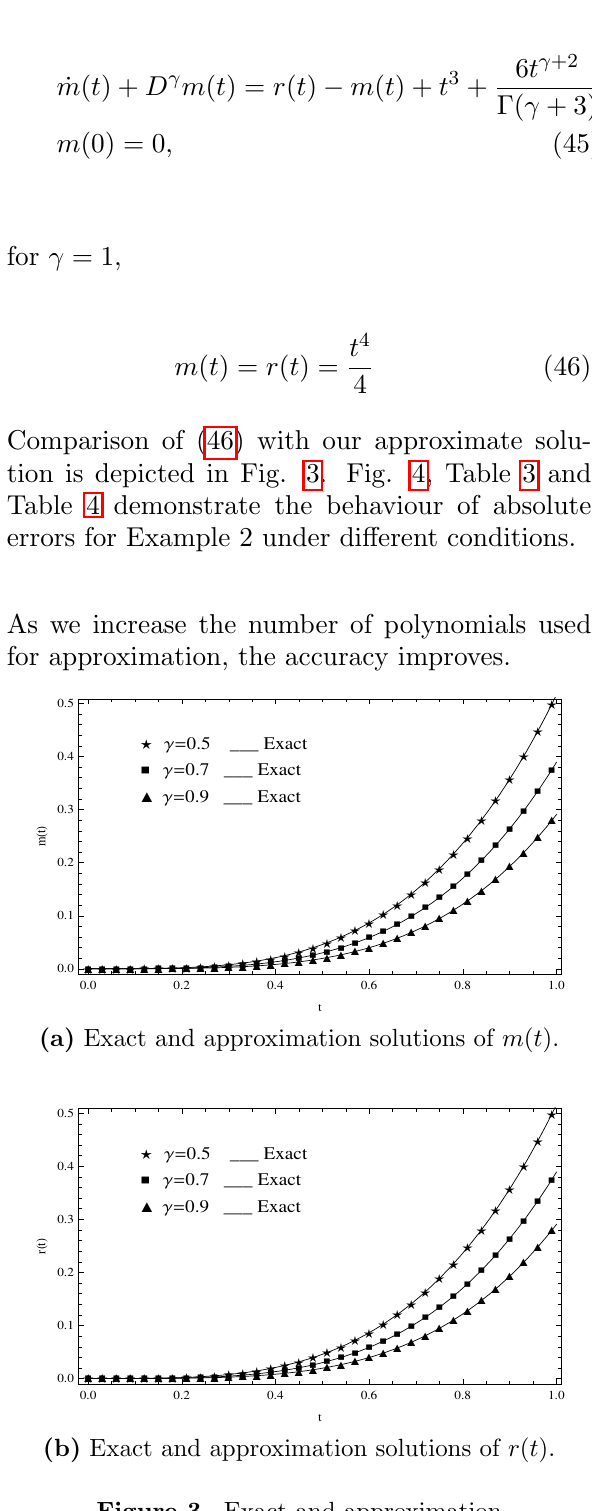
Figure 3. Exact and approximation solutions of m ( t ) and r ( t ) for N = 5 in Example